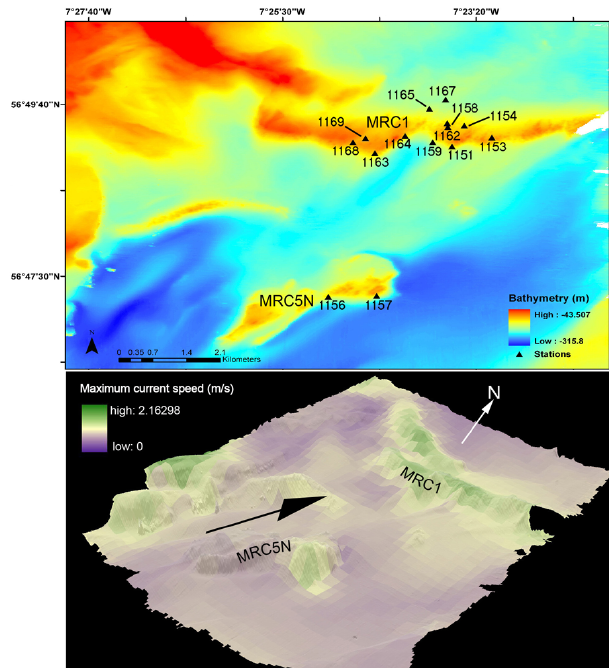
Fig. 2. Grab stations on the reef complex ( n = 14) in relation to bathymetry (top) and hydrography (bottom). In the bottom image, prevailing SSW to NNE currents are indicated by a black arrow, with north indicated by a white arrow. Mingulay Area 1 = MRC1, Mingulay 5 North =